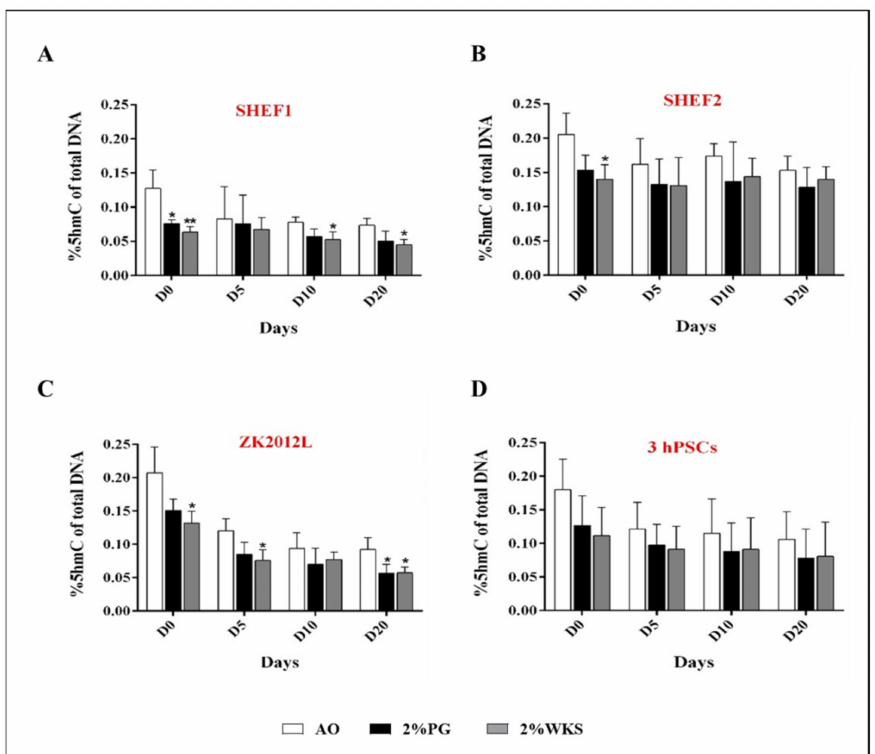
Figure 4. Global 5hmC levels PSCs. ( A ) SHEF1, ( B ) SHEF2, ( C ) ZK2012L, and ( D ) Pooled PSCs- profile, (SHEF1, SHEF2 and ZK2012L) . The methylated DNA fragments of PSCs were analysed using MethylFlash Global Hydroxymethylated DNA (5-hmC) Quantification Kit. Y -axis shows absorbance (450 nm) of 5-hydroxymethylcytosine. The X -axis indicates different time points (days). Data are presented as a mean ( n = 3), * p < 0.05, ** p < 0.01 vs. 21% AO, connecting lines indicate significance between conditions, and error bars indicate